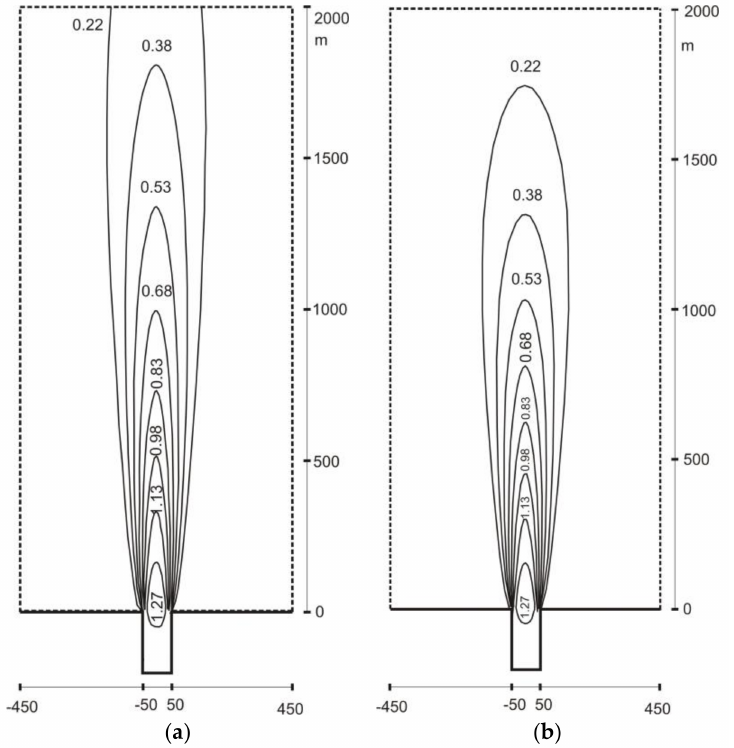
Figure 5. Linear contours of longitudinal velocity (m/s): ( a ) jet alone; ( b ) jet interacting with waves according to T5M